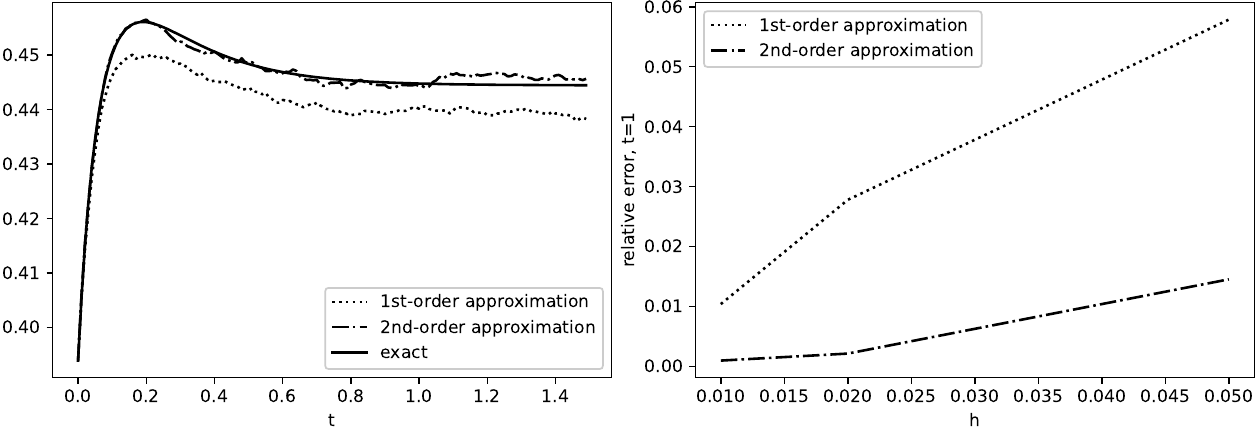
) and E f ( X x ) as functions of t and h for f ( x ) = x 5 : x = 0.83, t t